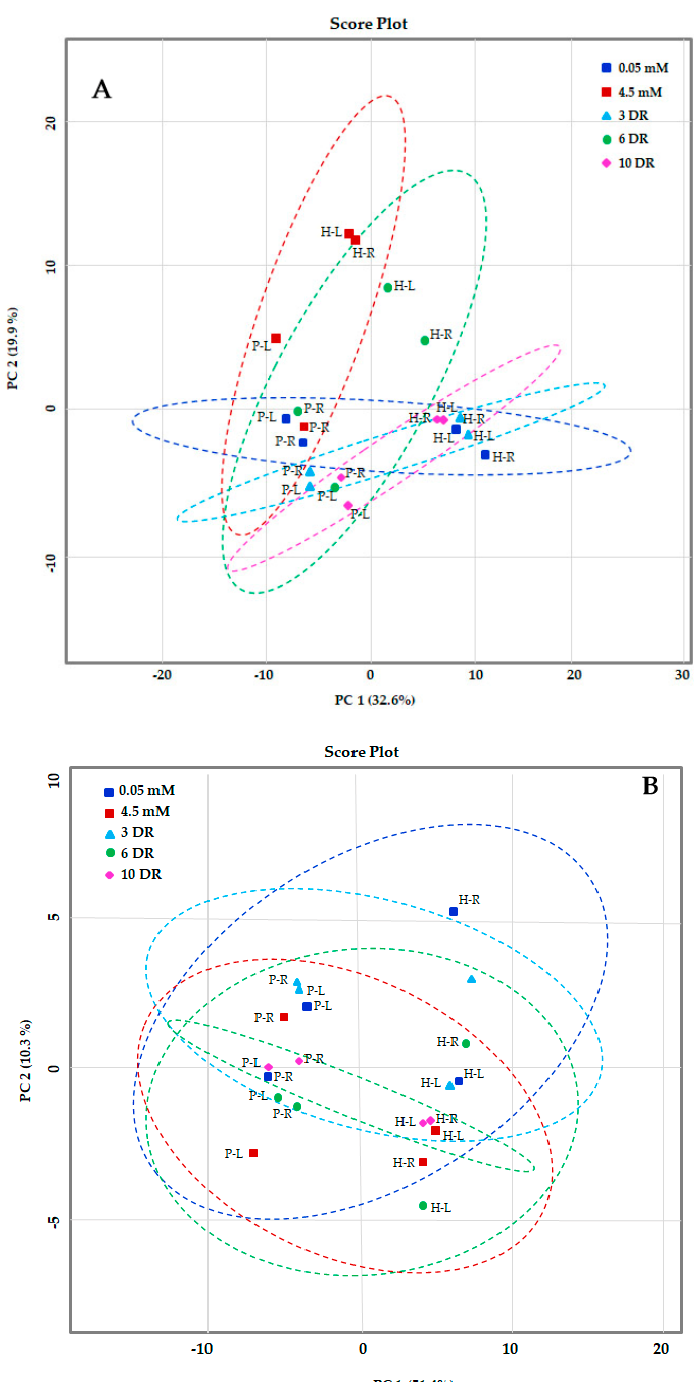
Figure 1. Principal component analysis of the GC–MS ( A ) and LC–MS ( B ) based metabolic profile of the leaf and root of PEHM-2 and HM-4 maize genotypes under low-N (0.05 mM) and its recovery and sufficient-N (4.5 mM) conditions. The principle component analysis (PCA) score plot distinguishes the metabolic profiles of low-N sensitive and low-N tolerant maize genotypes. Legend for variables: PEHM-2 leaf (P-L), PEHM-2 root (P-R), HM-4 leaf (H-L), HM-4 root (H-R), 0.05 mM N (blue filled square), 4.5 mM N (red filled square), 3DR (sampling after 3rd day of resupply N, triangle), 6DR (sampling after 6th day of resupply N, circle) and 10DR (sampling after 10th day of resupply N, diamond). The first number in the data points represents treatment (0.05 mM N, 4.5 mM N, 3DR, 6DR and 10DR). The second number represents the genotype (P and H). The third number indicates the plant organ (leaf and root).